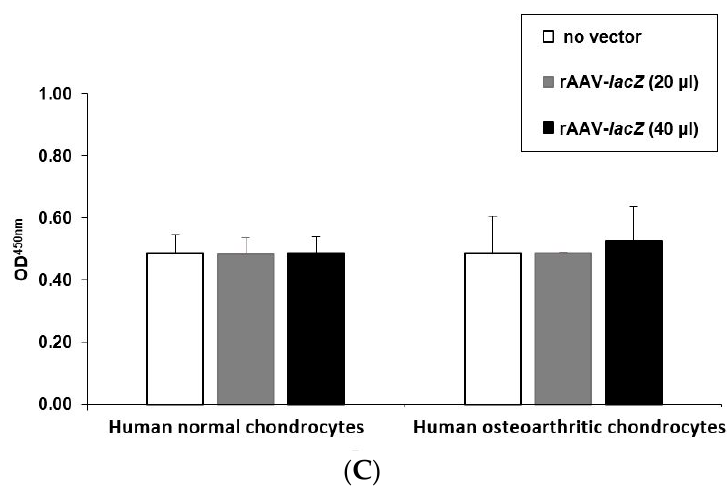
Figure 2. Safe transgene ( lacZ ) expression in rAAV-transduced aggregate cultures of human normal and OA chondrocytes. Cell aggregates were transduced with rAAV- lacZ (20 or 40 µ L) versus lack of vector treatment as described in Figure 1 and in the Materials and Methods. lacZ expression (A, B) was monitored after 21 days by X-Gal staining ( A ); all representative data; scale bars: 1 mm) and using the Beta-Glo ® Assay System ( B ) as described in the Materials and Methods. The relative cell proliferation indices in treated (rAAV- lacZ ) versus control aggregates (absence of vector condition) ( C ) were monitored after 21 days using the Cell Proliferation Reagent WST-1 as described in the Materials and Methods. Statistically significant compared with *no vector treatment and + rAAV- lacZ (20 µ L).